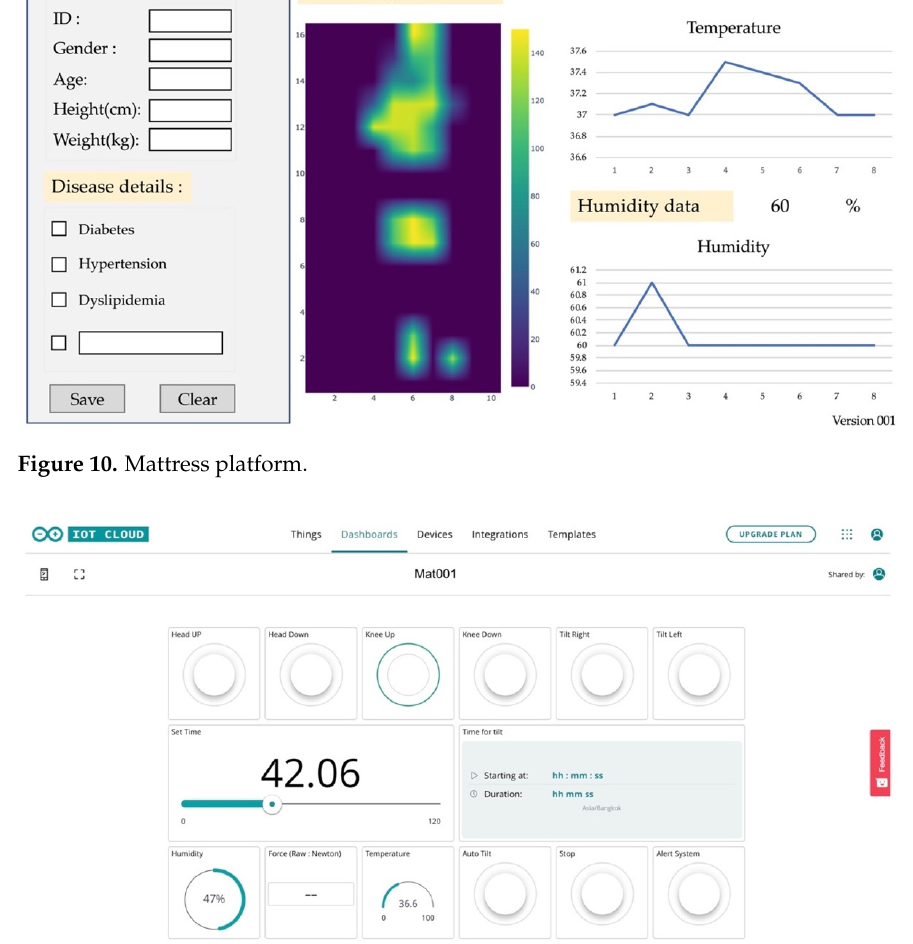
Figure 11. Dashboard monitor structure.